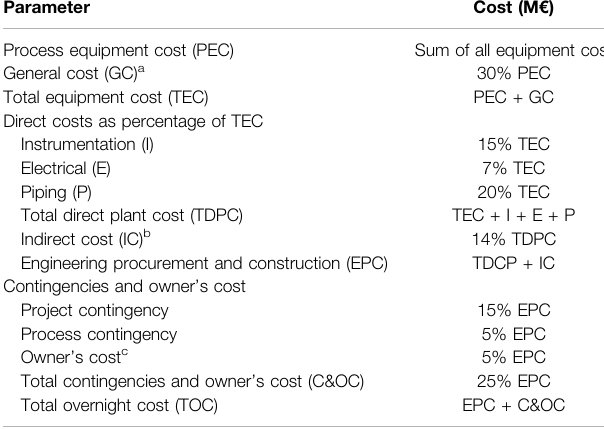
TABLE 8 | TOC calculation